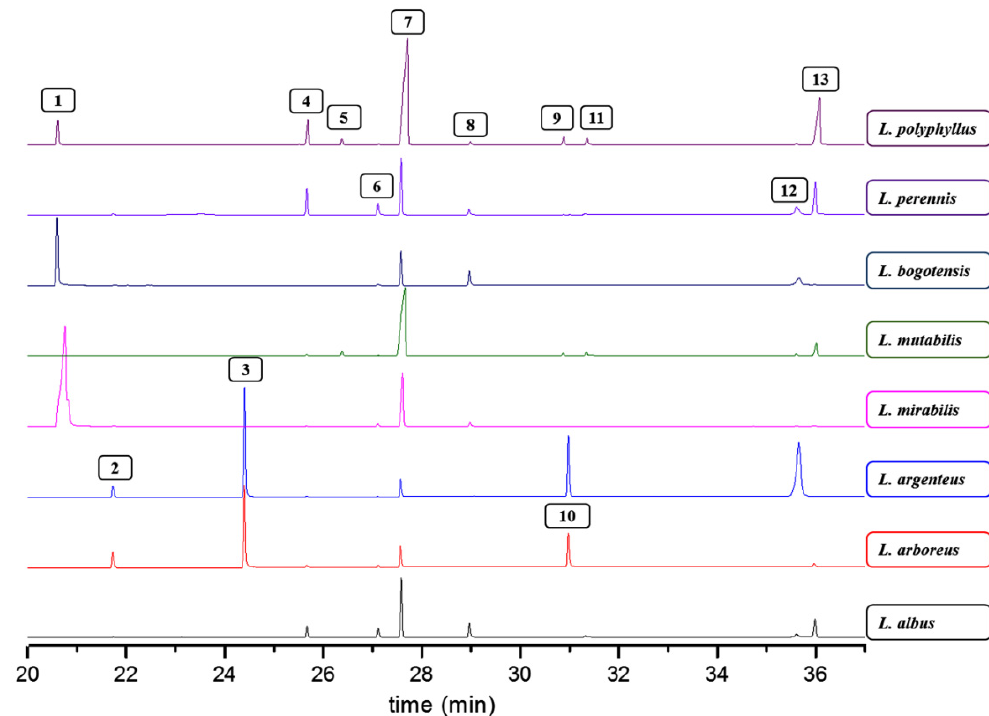
Figure 1. Stacked GC-MS chromatograms of quinolizidine-rich extracts (QREs) were obtained from the eight species of Lupinus . The box-enclosed numbers represent each identified quinolizidine listed in Table 1.